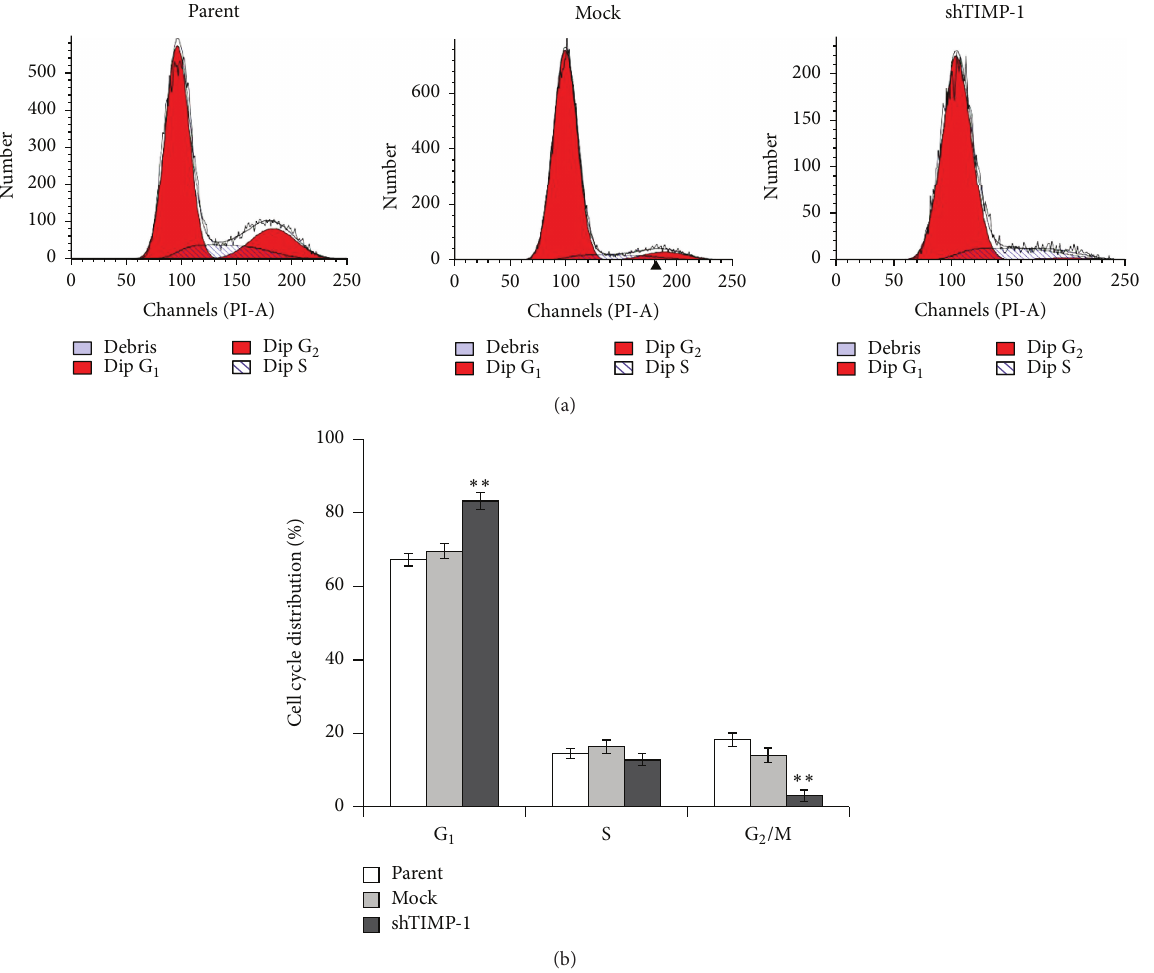
Figure 5: TIMP-1 knockdown blocked cell cycle progression. Cells were stained with propidium iodide and cell cycle distribution was then analyzed using flow cytometry 72 h after infection. (a) Representative images of cell cycle distribution in parental, mock-shRNA, and shTIMP- 1 ADSCs. (b) The histogram was the statistical data from three independent experimental replicates. ∗∗ 𝑃 < 0.01 versus the mock-shRNA